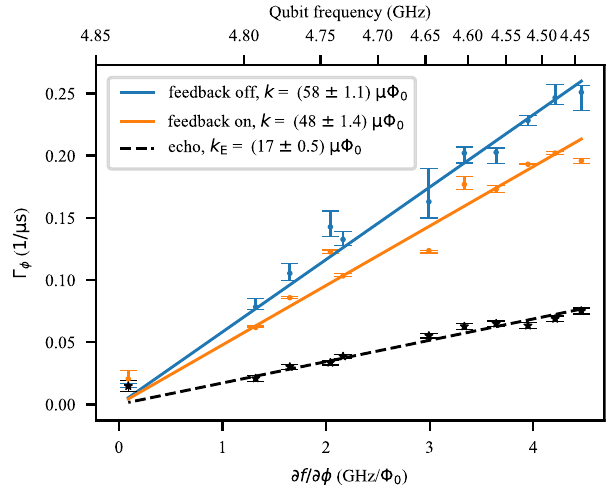
Fig. 3 Qubit coherence at different bias points. The qubit dephasing rate Γ ϕ is evaluated at several different bias fl uxes. Qubit ’ s sensitivity to fl ux noise increases further away from the sweet spot, resulting in reduced dephasing times (increased dephasing rates). The error bars show 68% con fi dence intervals for the median of the dephasing rates measured 60 times. The solid lines show a linear fi t to the dephasing rates with respect to the curvature of the qubit spectrum with respect to fl ux. The black stars show the dephasing rates extracted from a spin-echo experiment, used as a